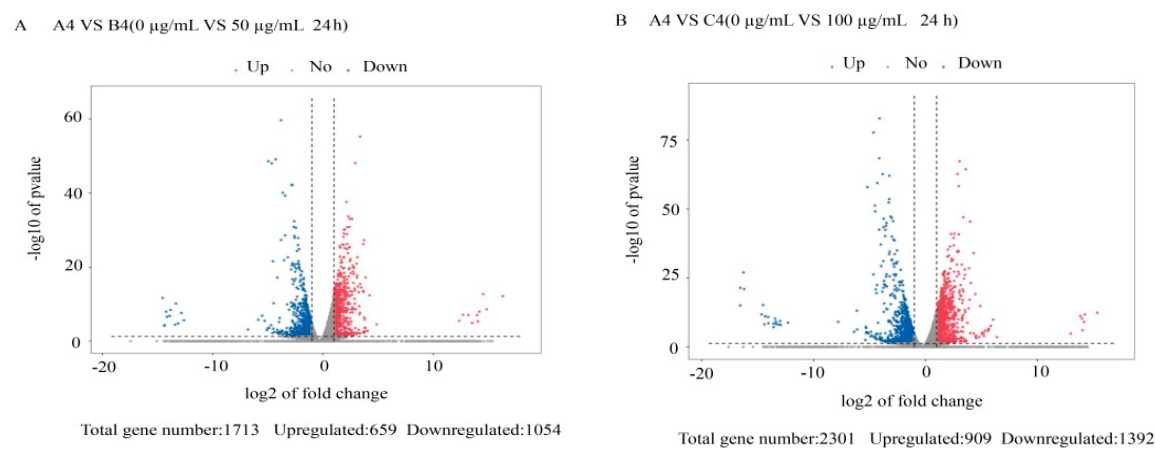
Figure 3. Volcanic map analysis of DEGs in M. oryzae after treatment with citral for 24 h. ( A ) Volcanic map analysis of DEGs in M. oryzae after treatment with citral (0 µ g/mL and 50 µ g/mL) for 24 h. ( B ) Volcanic map analysis of DEGs in M. oryzae after treatment with citral (0 µ g/mL and 100 µ g/mL) for 24 h.Red represents upregulated significantly differentially expressed genes, blue represents downregulated significantly differentially expressed genes, and gray dots represent non significantly differentially expressed genes.